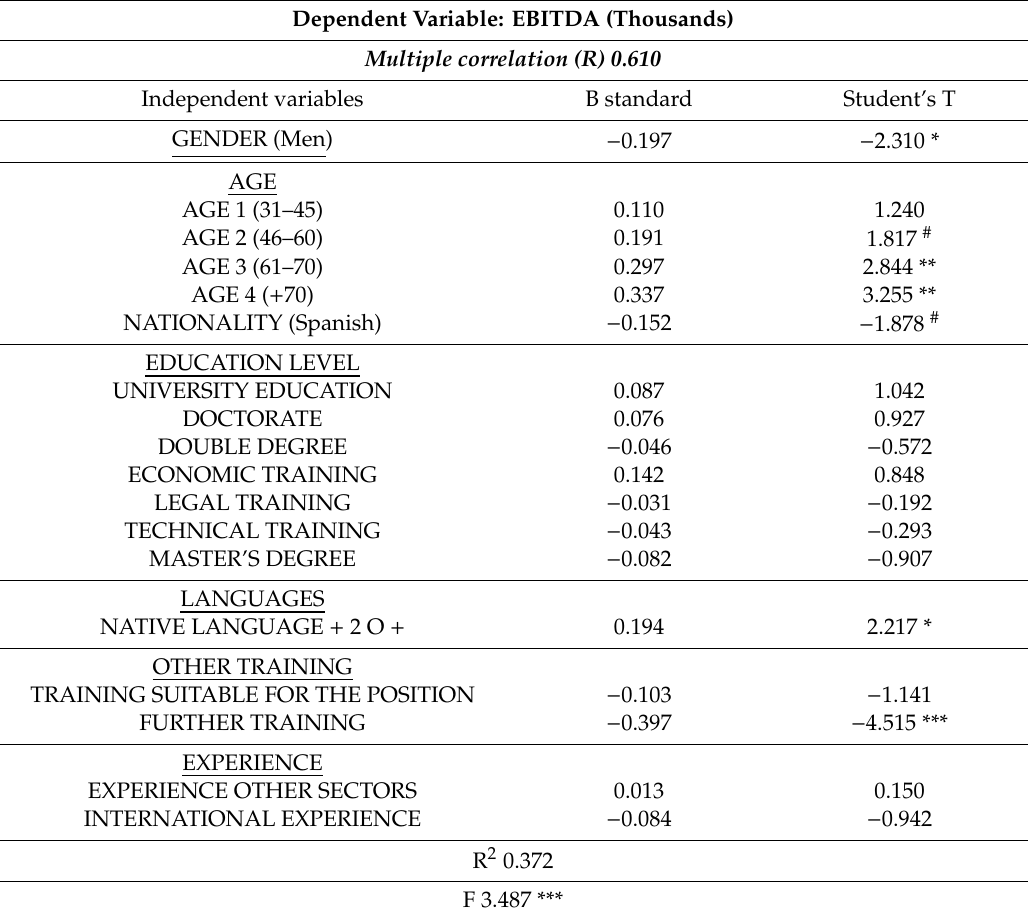
Table 3. Variables of influence on EBITDA in the IBEX 35 companies.